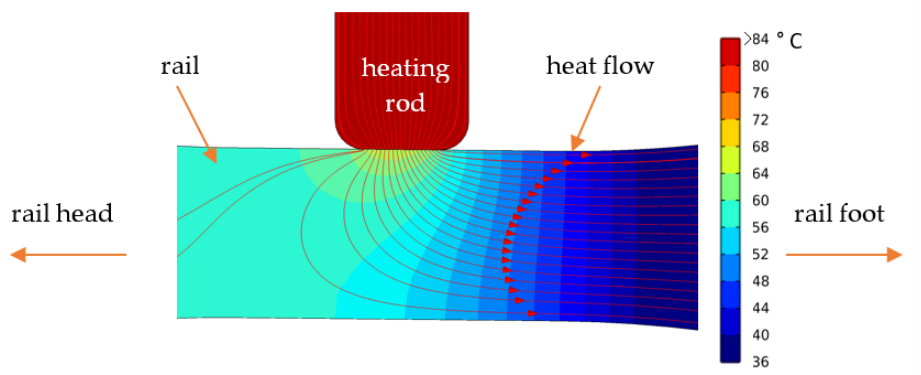
Figure 11. Isotherms and heat flow are displayed in the cross-section of the heating rod and rail from a previous calculation.